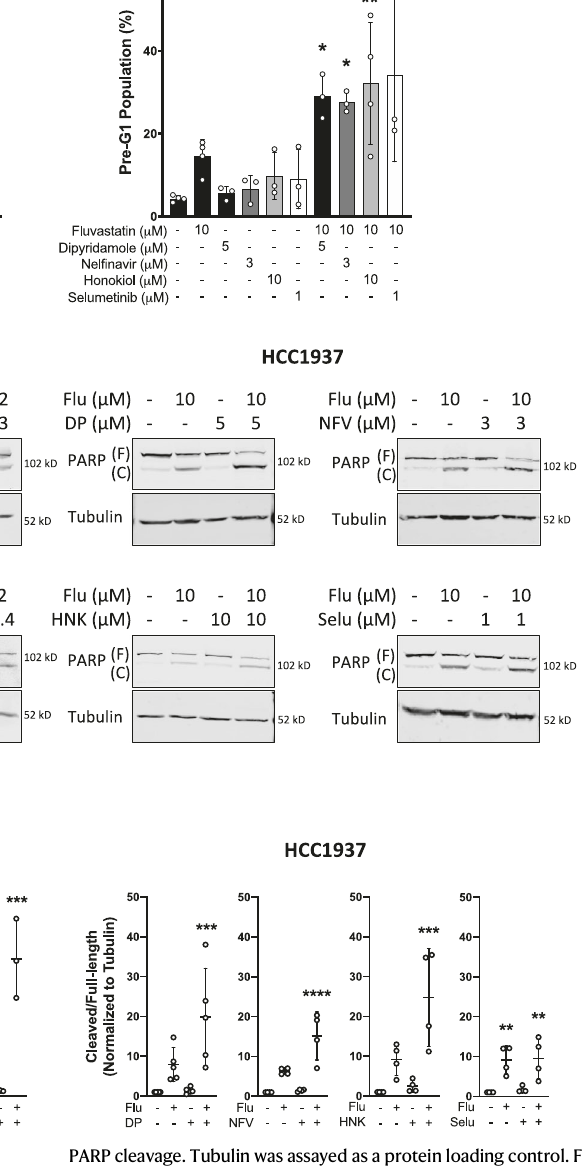
death. a MDA-MB-231 and HCC1937 cells were treated with solvent controls or fl uvastatin+/ − dipyridamole(DP),nel fi navir(NFV),honokiol(HNK)orselumetinib (Selu) for 72h, fi xed in ethanol and assayed for DNA fragmentation (% pre-G1 population) as a marker of cell death by propidium iodide staining. Error bars represent the mean±SD, n =3 – 4 biologically independent samples, * p <0.05, ** p <0.01,**** p <0.0001(one-wayANOVAwithBonferroni ’